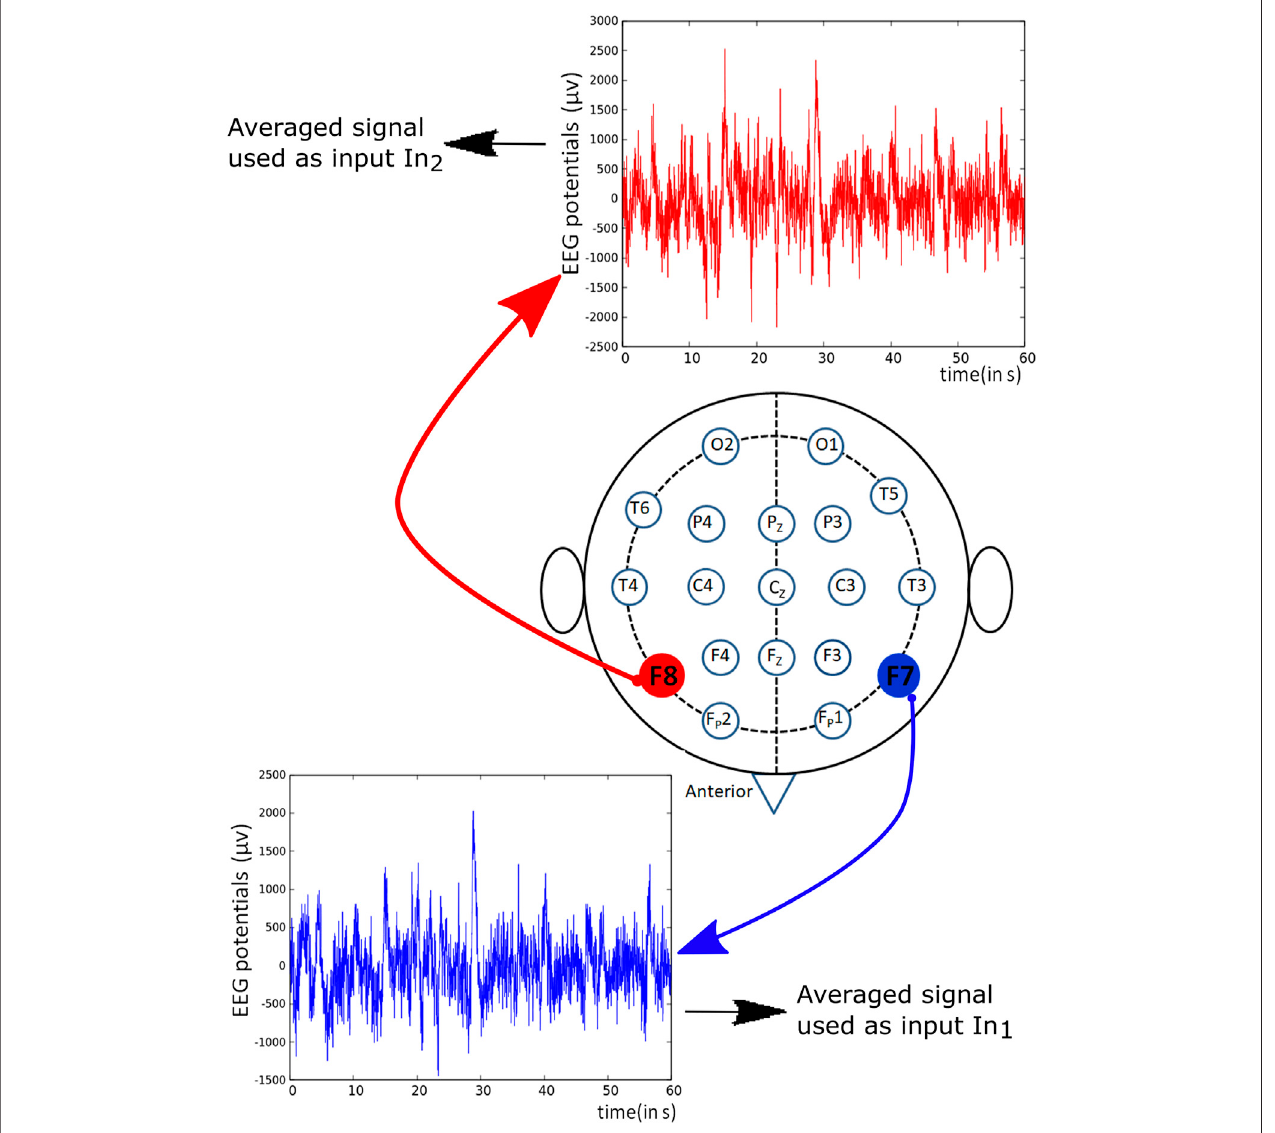
FIGURE 3 | Schematic representation of positions of different electrodes used for recording EEG potentials. The potentials derived from the marked red channels were used to generate predictors in the training dataset T S .